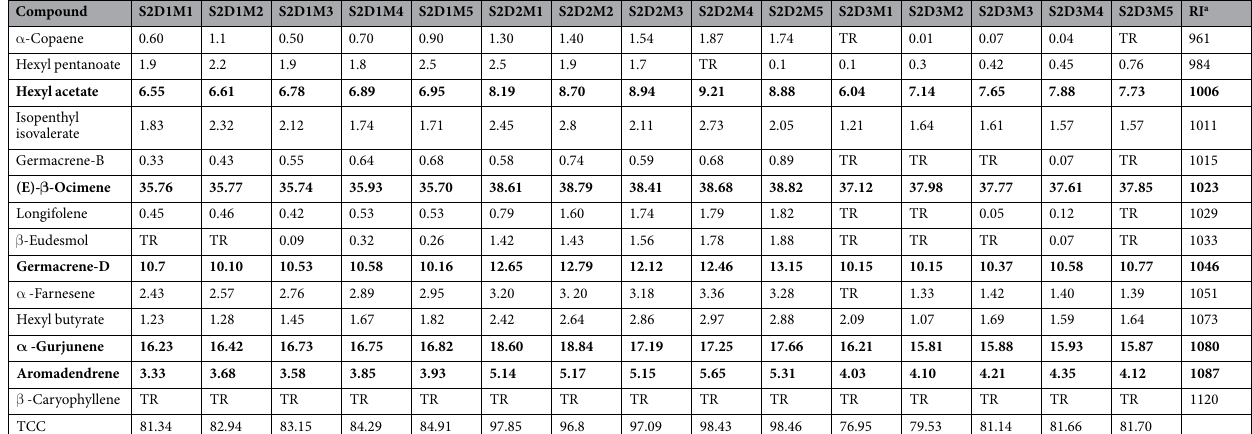
Table 4. Essential oil compound of Salvia reuterana Boiss., under different irrigation regimes and melatonin treatments. S2:Salvia reuterana Boiss. D1: irrigation at 80% Fc, D2: irrigation at 60% Fc, D3: irrigation at